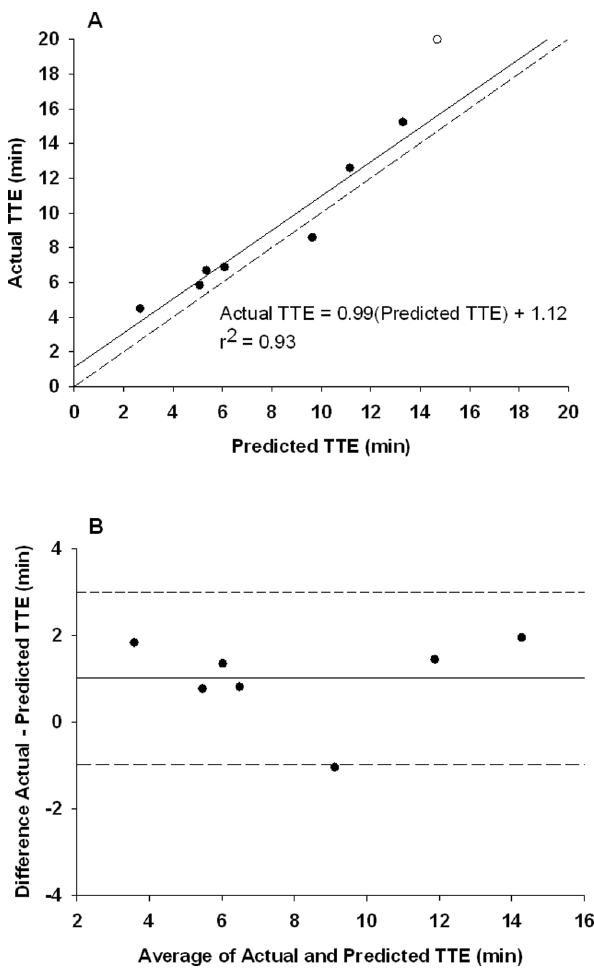
Figure 6. Predicted vs. actual time to exhaustion (TTE) in constant supra-fCF impulse intensity exercise tests. Panel A: Regression of predicted vs. actual TTE (closed circles), excluding data for subject 7 whose actual TTE was constrained by the 20 min limit of test duration (open circle). Panel B: Bland-Altman plot of TTE. Mean difference between predicted and actual TTE (solid line). 6 1.97 min 95% limits of agreement (dashed lines).